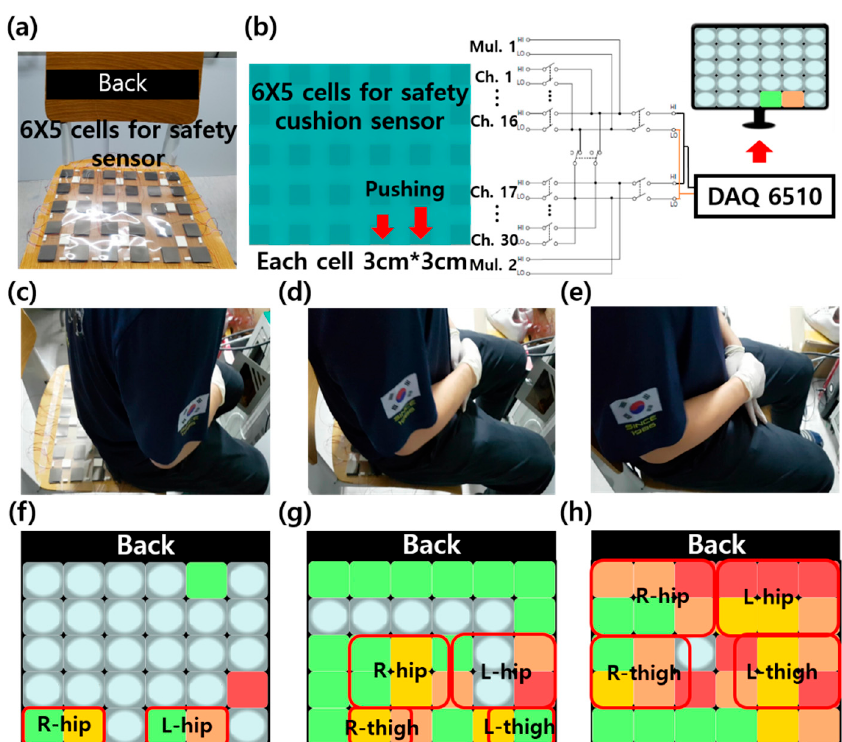
Figure 5. Self-powered safety cushion sensor. ( a ) A photograph of the 6 × 5 cells for the safety sensor, total size of 33 cm × 27 cm; each cell has a size of 3 cm × 3 cm. ( b ) The schematic and circuits of the safety cushion sensor. ( c – e ) Detection of human sitting, front, middle, and back of the sensor array. ( f – h ) The two-dimensional contour plot via monitoring in real time.